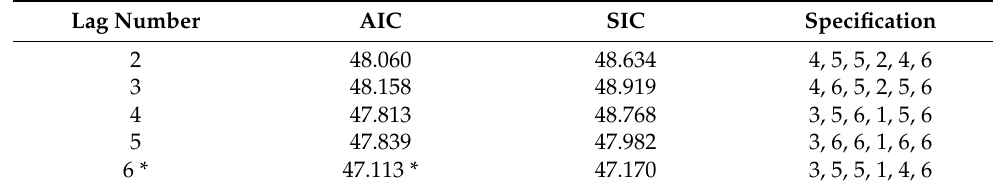
Table 4. Lag Selection